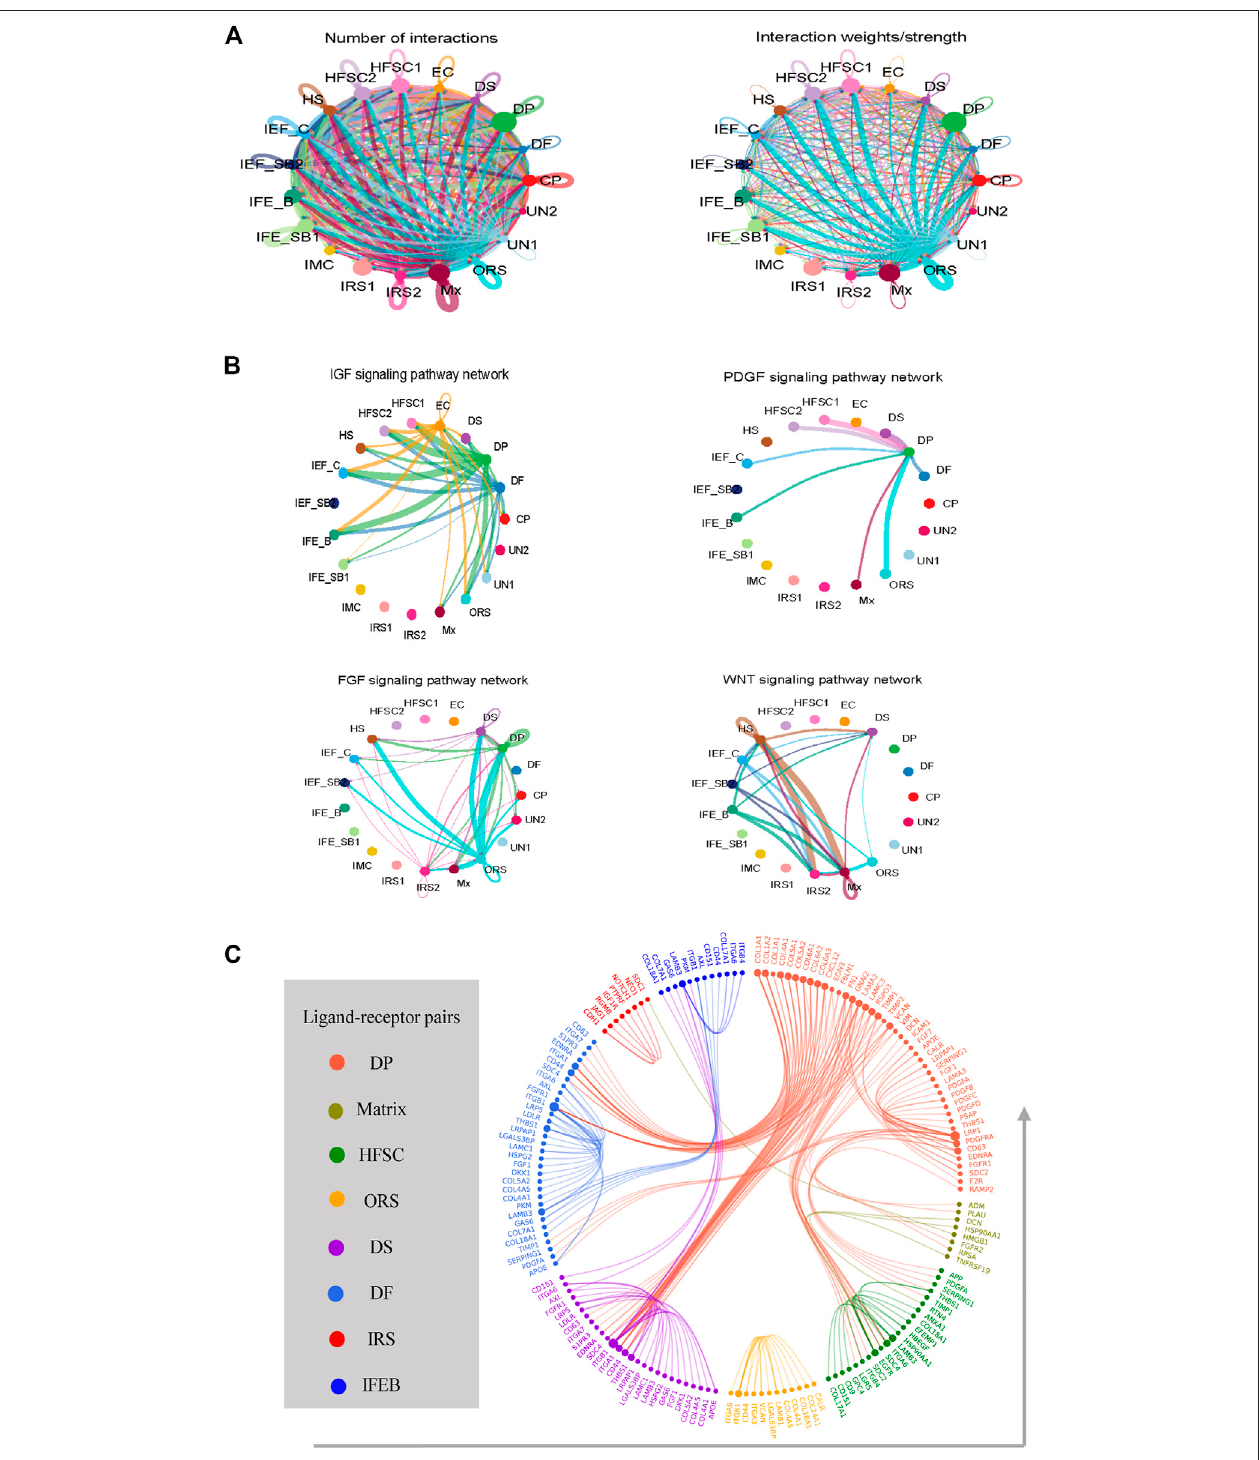
FIGURE5| Intercellularligand – receptorprediction. (A) Analyzethenumberofinteractionsandinteractionstrengthamongdifferentcellpopulations. (B) Identifythe signaling pathways among different cell populations. (C) Ligand – receptor pairs between main cell populations. Different cell populations are color-coded, and ligand – receptor pairs are linked with a solid line.